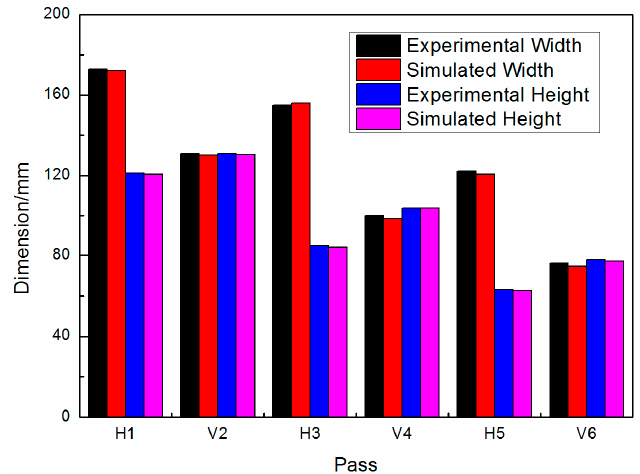
Figure 6. Comparison of experimental and simulated billet sizes at exit of each pass.